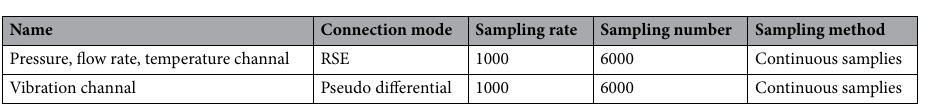
Table 1. The selection of specific